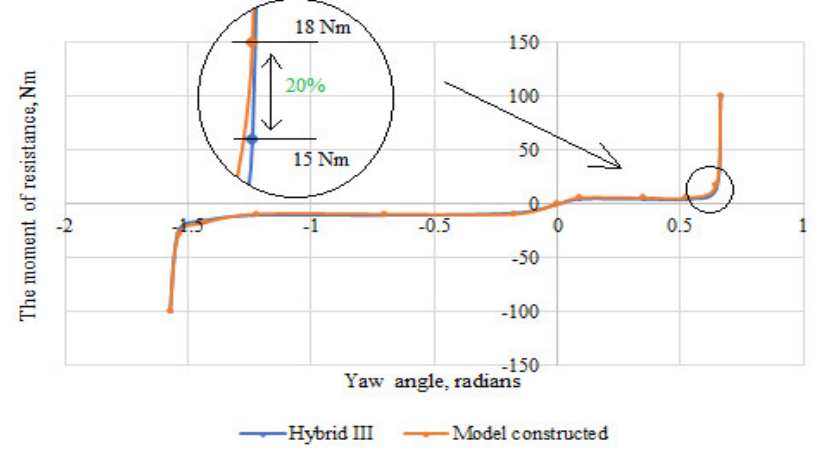
Figure 14. Summary of the stiffness characteristics of the elbow joint of the constructed